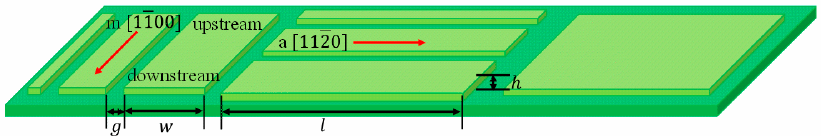
Figure 1. Schematic perspective view of the patterned GaN substrates, in which g (=20 µ m) is the spacing of stripes, w (=2/5/10/15/30/50 µ m) is the stripe width, l (=210 µ m) is the stripe length and h (=0.5 µ m) is the stripe height, respectively. The patterns include three regions: stripes along the m-direction ( left ), stripes along the a-direction ( middle ) and an unpatterned area ( right ). Afterwards, the samples were dipped into 25% tetramethylammonium hydroxide (TMAH) at 85 ◦ C for 20 min to remove the etching residuals on the surface and make a smoother sidewall [19]. About 100 nm un-intentionally doped GaN was then grown by metalorganic chemical vapor deposition (MOCVD) at temperature of 993 ◦ C (sample A) and 888 ◦ C (sample B). Trimethylgallium (TMGa) and ammonia were used as the gas sources, while nitrogen was used as the carrier